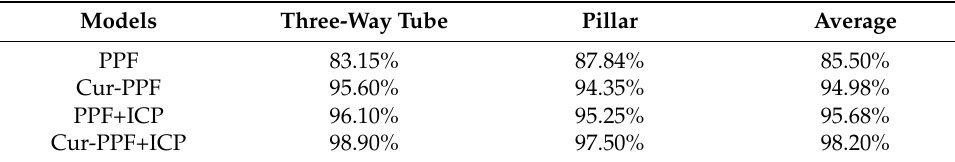
Table 6. The matching rate of PPF and Cur-PPF algorithms on real data sets. Models